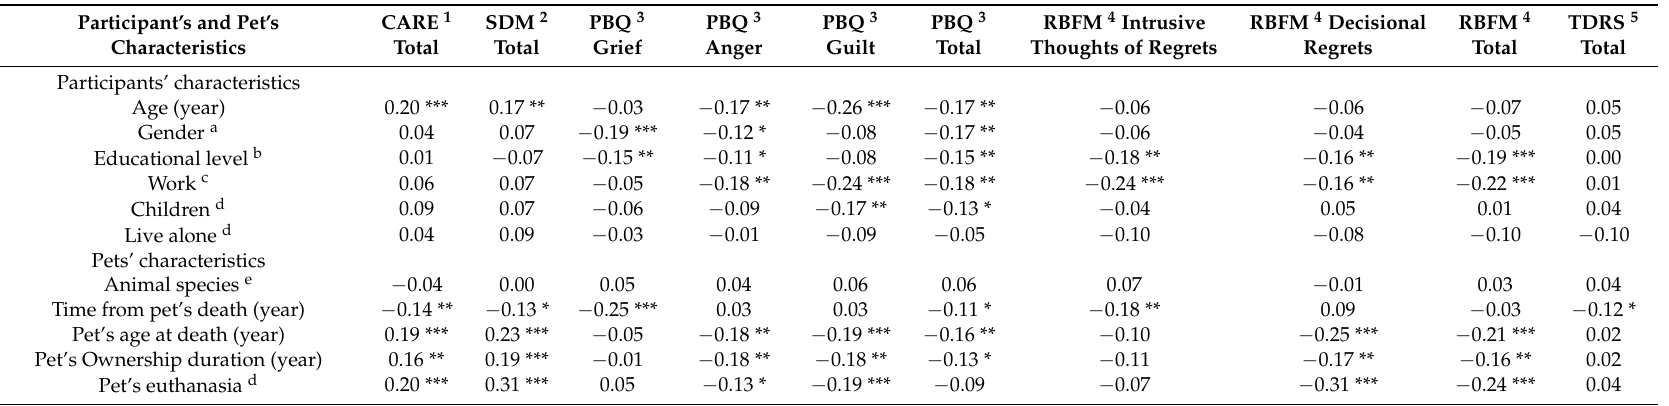
Table 3. Correlation of study variables with participants’ characteristics and companion animal’s